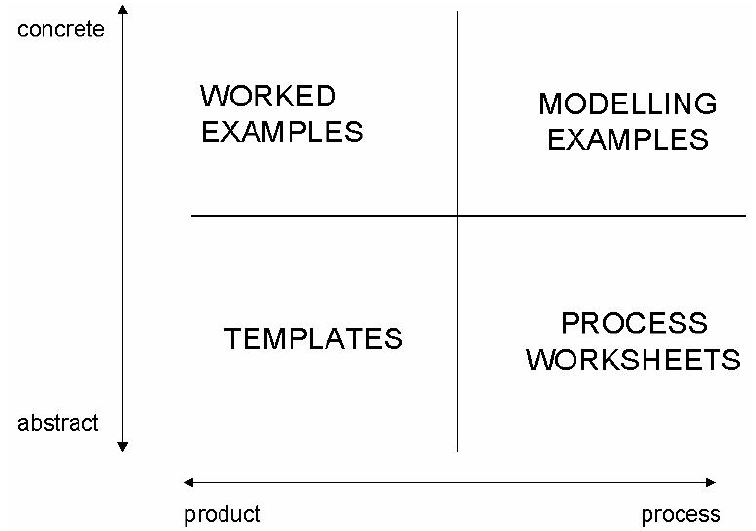
Figure 2. Four basic formats for cognitive